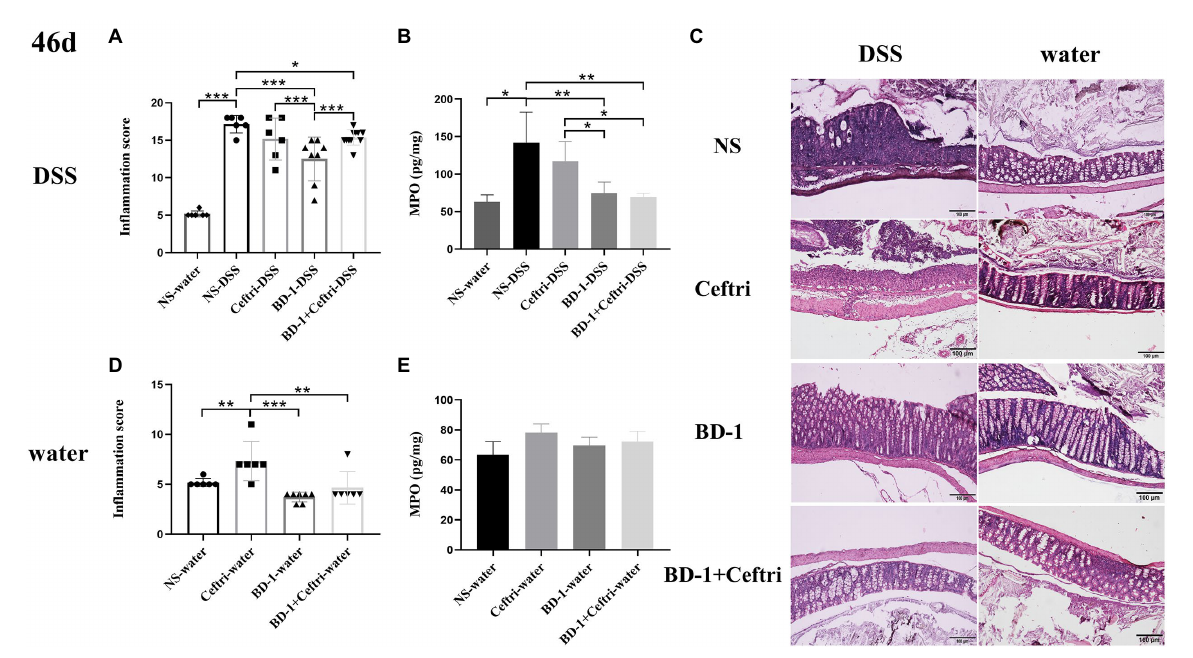
FIGURE 1 Colonic inflammation after Dextran sulfate sodium (DSS) induction (46 days, n = 6). (A) Inflammatory pathology score (DSS groups). (B) Myeloperoxidase activity (DSS groups). (C) Typical histological images of H&E-stained colonic tissue in NS-DSS group, NS-water group, Ceftri- DSS group, Ceftri-water group, BD-1-DSS group, BD-1-water group, BD-1 + Ceftri-DSS group, and BD-1 + Ceftri-water group. Microscope magnification: 10x and 10x. (D) Inflammatory pathology score (water groups). (E) Myeloperoxidase activity (water groups). * p < 0.05, ** p < 0.01, and *** p < 0.001 as